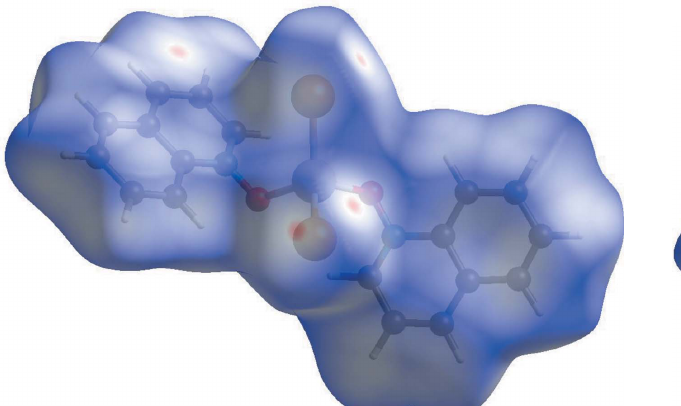
Figure 9 Hirshfeld surface for ( II ) mapped over d norm .